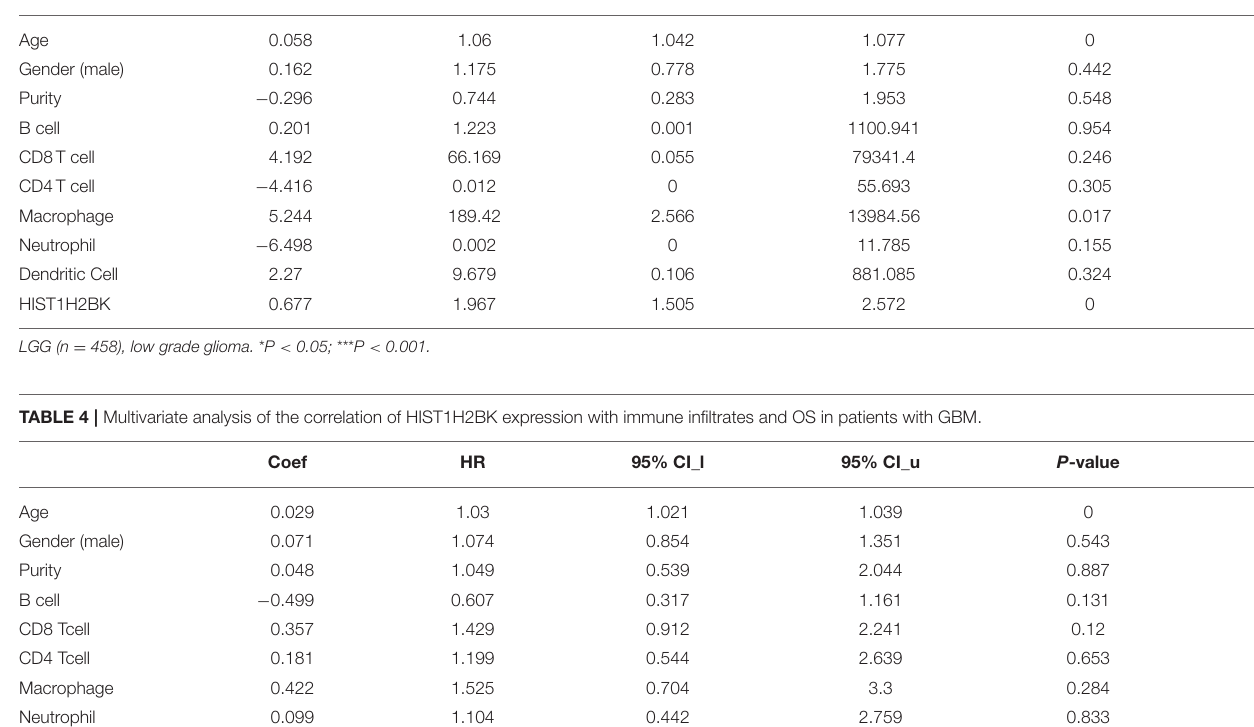
TABLE 3 | Multivariate analysis of the correlation of HIST1H2BK expression with immune infiltrates and OS in patients with LGG. Coef HR 95% CI_l 95% CI_u